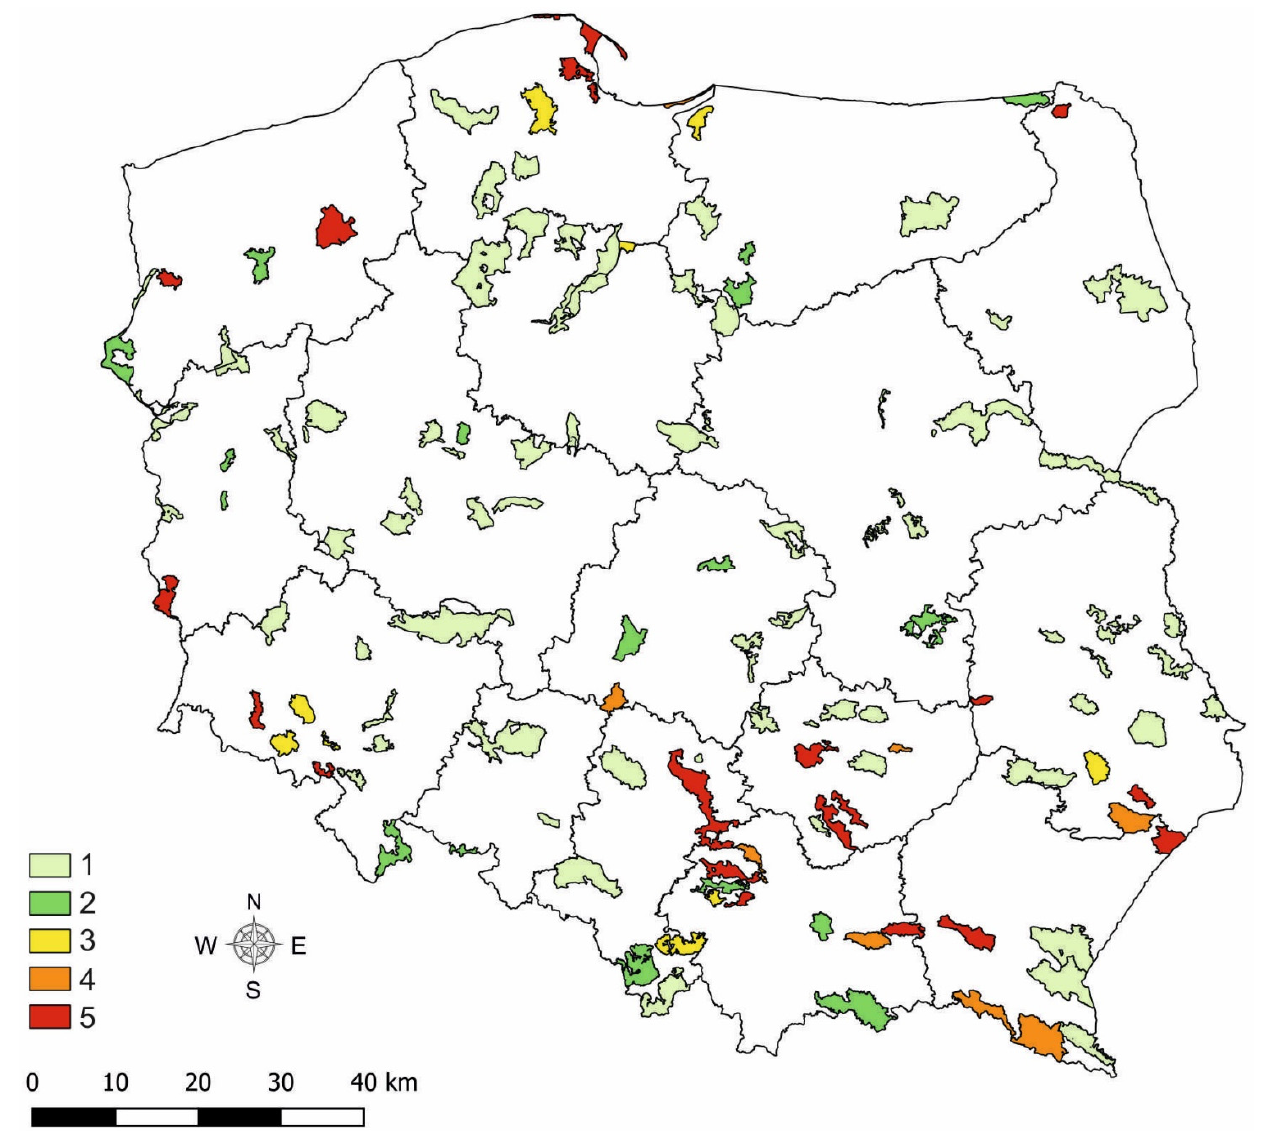
Figure 4. Density of geosites within landscape parks (per 100 km 2 ). 1: <2.6, 2: 2.6–5.0, 3: 5.1–7.5, 4; 7.6–10.0, 5: >10.